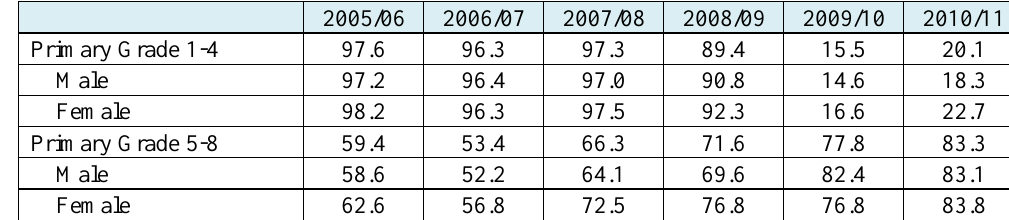
Table 4-14: Percentage of Qualified Teachers (2005/06 - 2010/11)